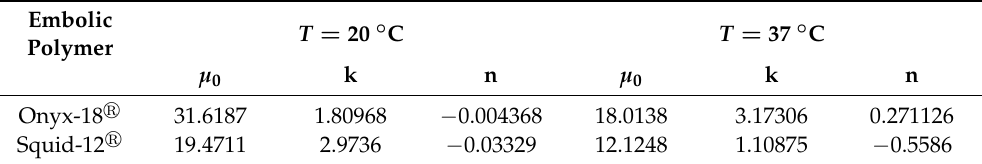
Table 3. Values of empirical constants of the CM for the studied embolic polymers at laboratory (20 ◦ C) and physiological (37 ◦ C)